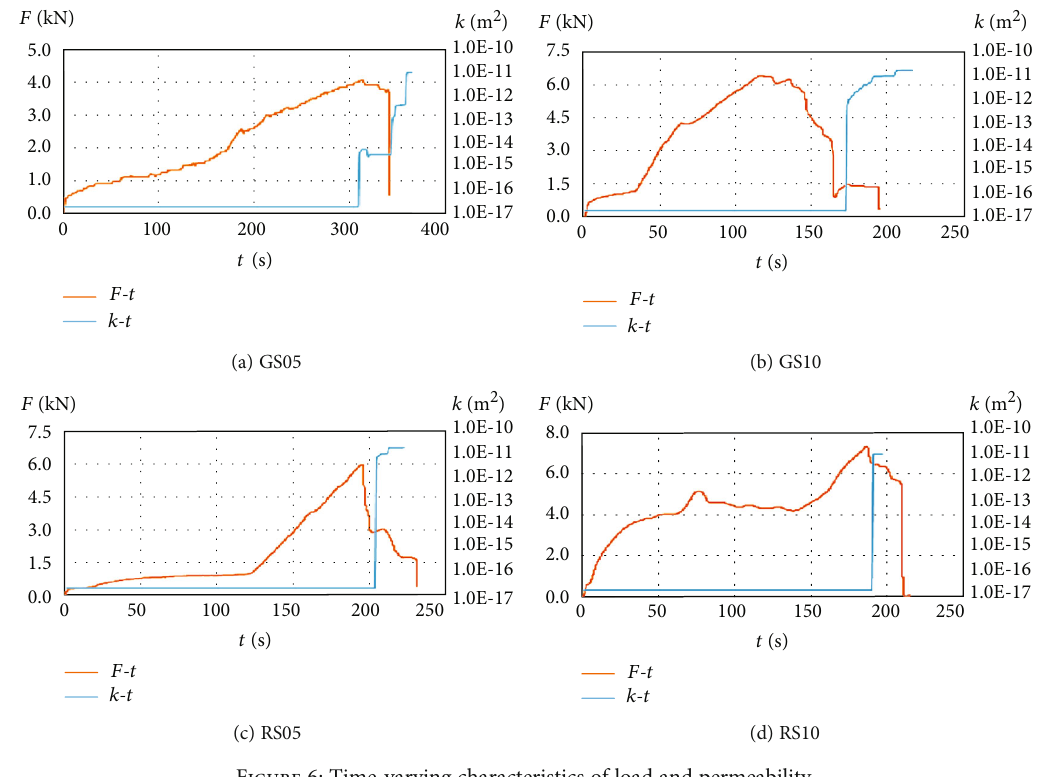
Figure 6: Time-varying characteristics of load and permeability. Table 3: The lagging times for di ff erent